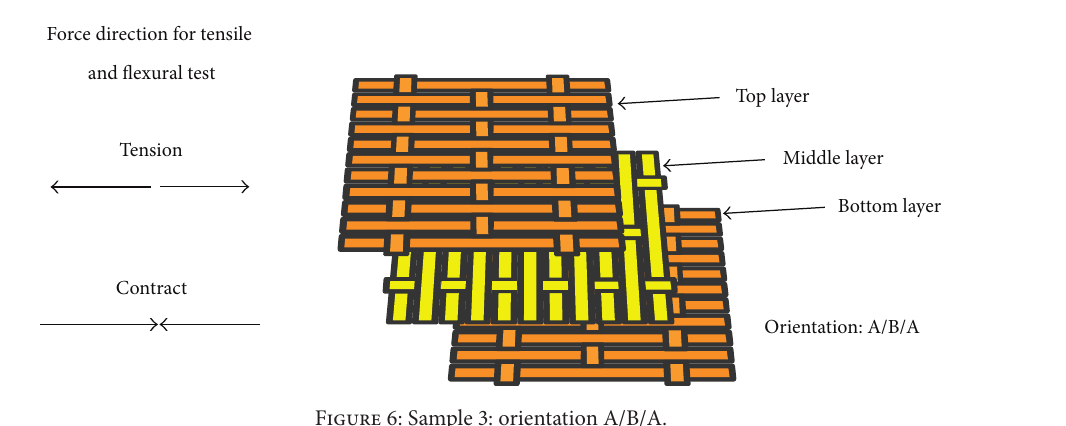
Figure 6: Sample 3: orientation A/B/A.